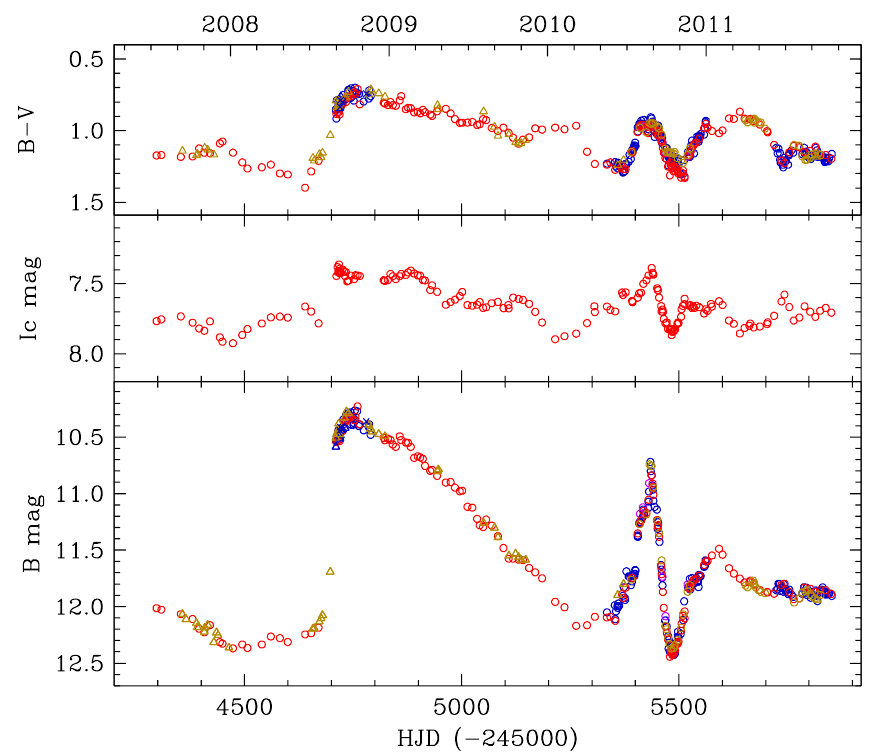
Fig. 4. The light curve of the current outburst of CI Cyg. Different symbols and colors identify data from different ANS